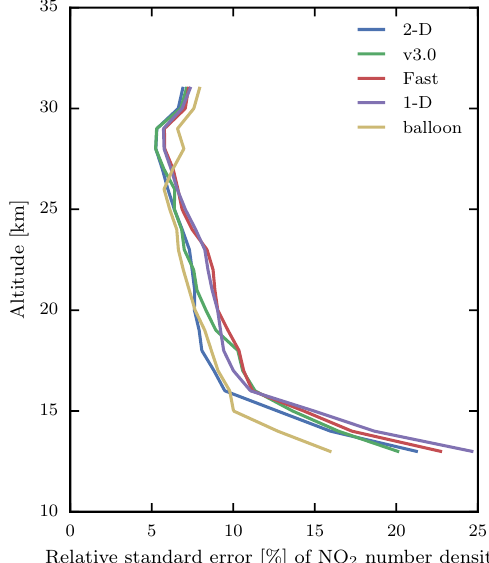
Figure 4. Sample size of coincident balloon data vs. altitude and as a function of retrieval algorithm. Sample size vs. height for 2-D mode is identical to that for 1-D mode.